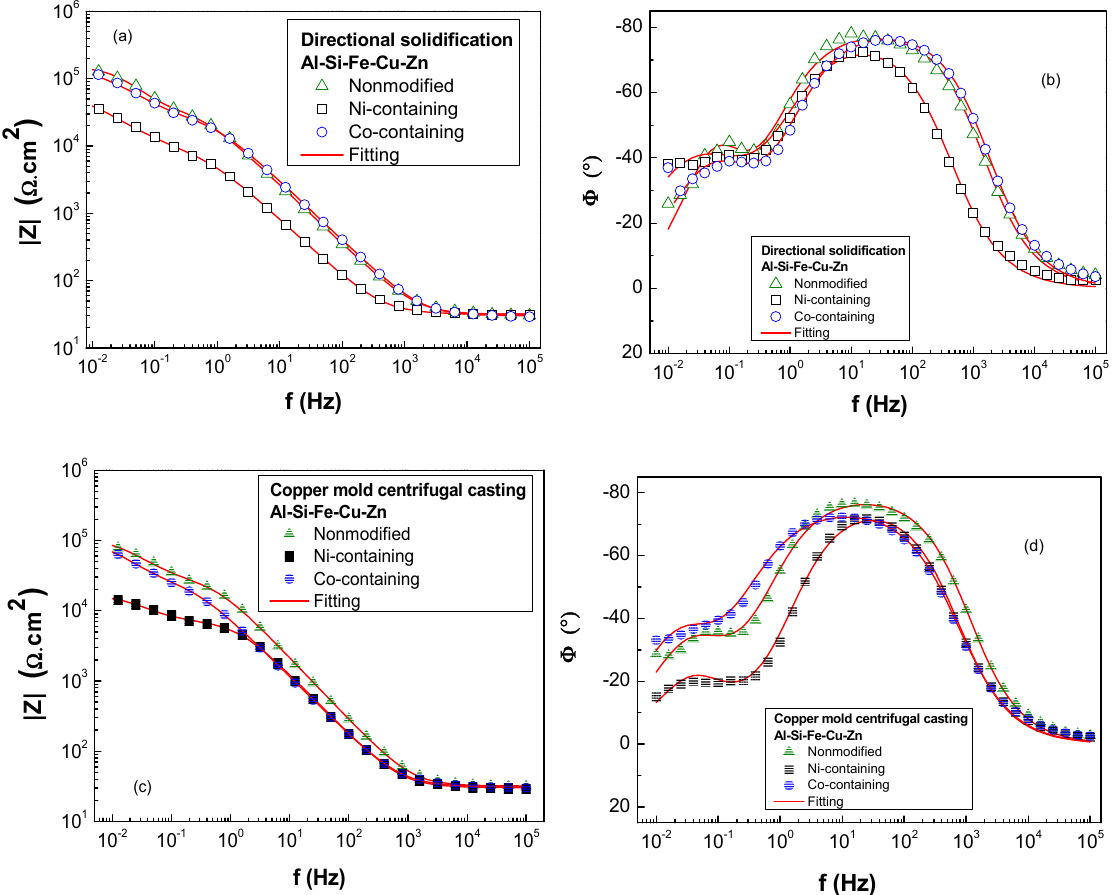
Figure 7. Bode and Bode-phase plots related to the Al-Si-Fe-Cu-Zn (-Co, -Ni) alloy samples having different SDAS: Approximately ( a , b ) 21 µ m, ( c , d ) 5 µ m.